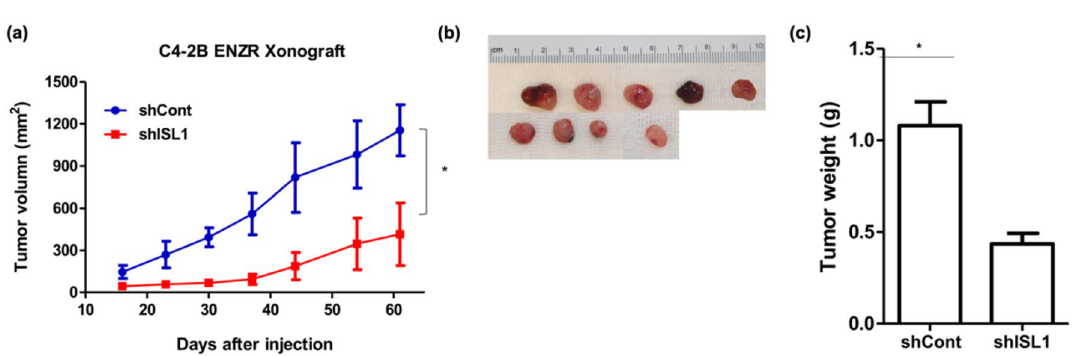
Figure 6. Depletion of ISL1 sensitizes enzalutamide-resistant C4-2B cells and decreases their epithelial-to- mesenchymal transition (EMT) properties. ( a ) Parental C4-2B and C4-2B-ENZR cells were subjected to western blot analysis for EMT gene expression. β-Actin was used to show equal loading. Full-length blots are presented in Supplementary Fig. S7. ( b ) C4-2B-ENZR cells transfected with siCont or siISL1 and subjected to western blot analysis for the indicated proteins. β-Actin was used to show equal loading. Full-length blots are presented in Supplementary Fig. S7. ( c ) Assessment of invasion of C4-2B-ENZR cells using Transwell migration assay. ( d ) C4-2B-ENZR cells transfected with siCont or siISL1 and the effects on p-p65 (S536) and p-AKT (S473) level were analyzed by western blot analysis; densitometry analysis of immune-reactive bands detected by western blots show that the ISL1 knockdown induced decrease in AKT phosphorylation over the basal was about twofold in C4-2B cells. Full-length blots are presented in Supplementary Fig. S7.